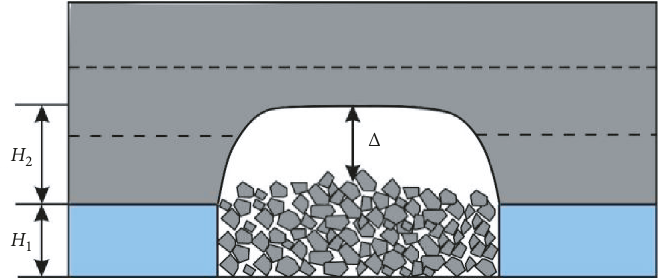
Figure 11: Schematic diagram of roof